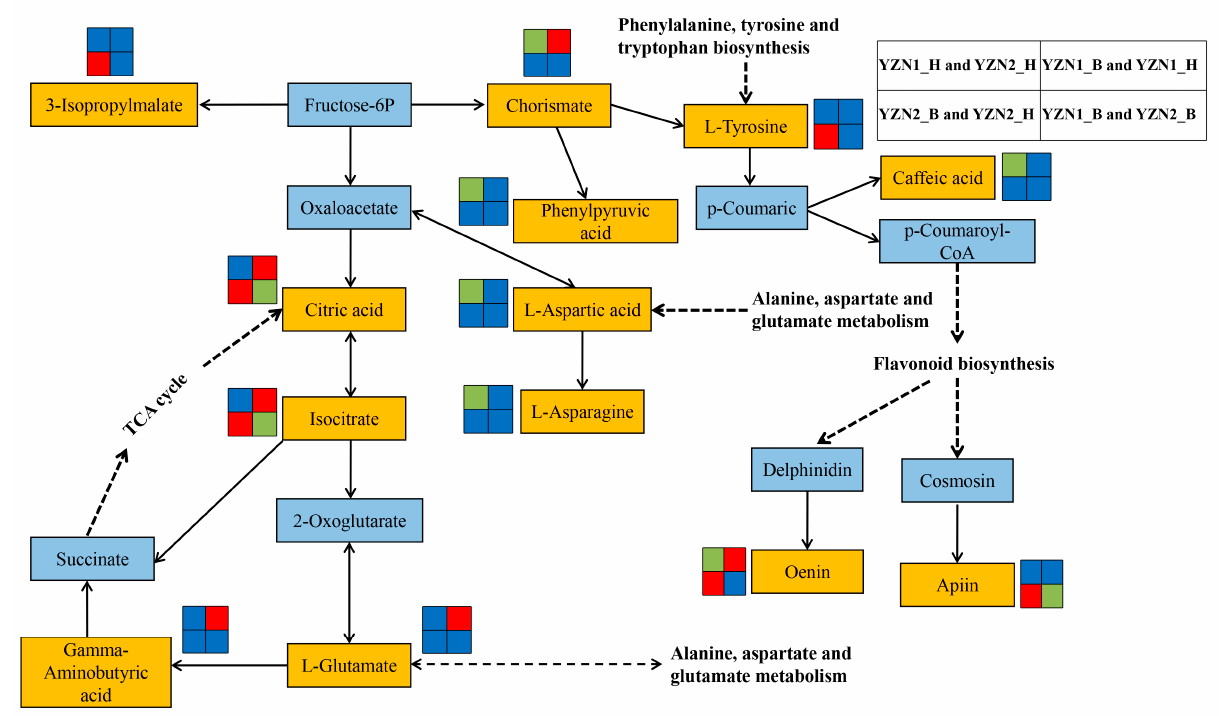
Figure 5. Overview of the possible regulatory network of some key metabolites in metabolic pathways in pairwise comparisons of two rice varieties before and after processing. The key metabolites are shown in the orange rectangles. Small red rectangles indicate significantly upregulated metabolites; small green rectangles indicate significantly downregulated metabolites; and small blue rectangles indicate no significant difference in metabolites.